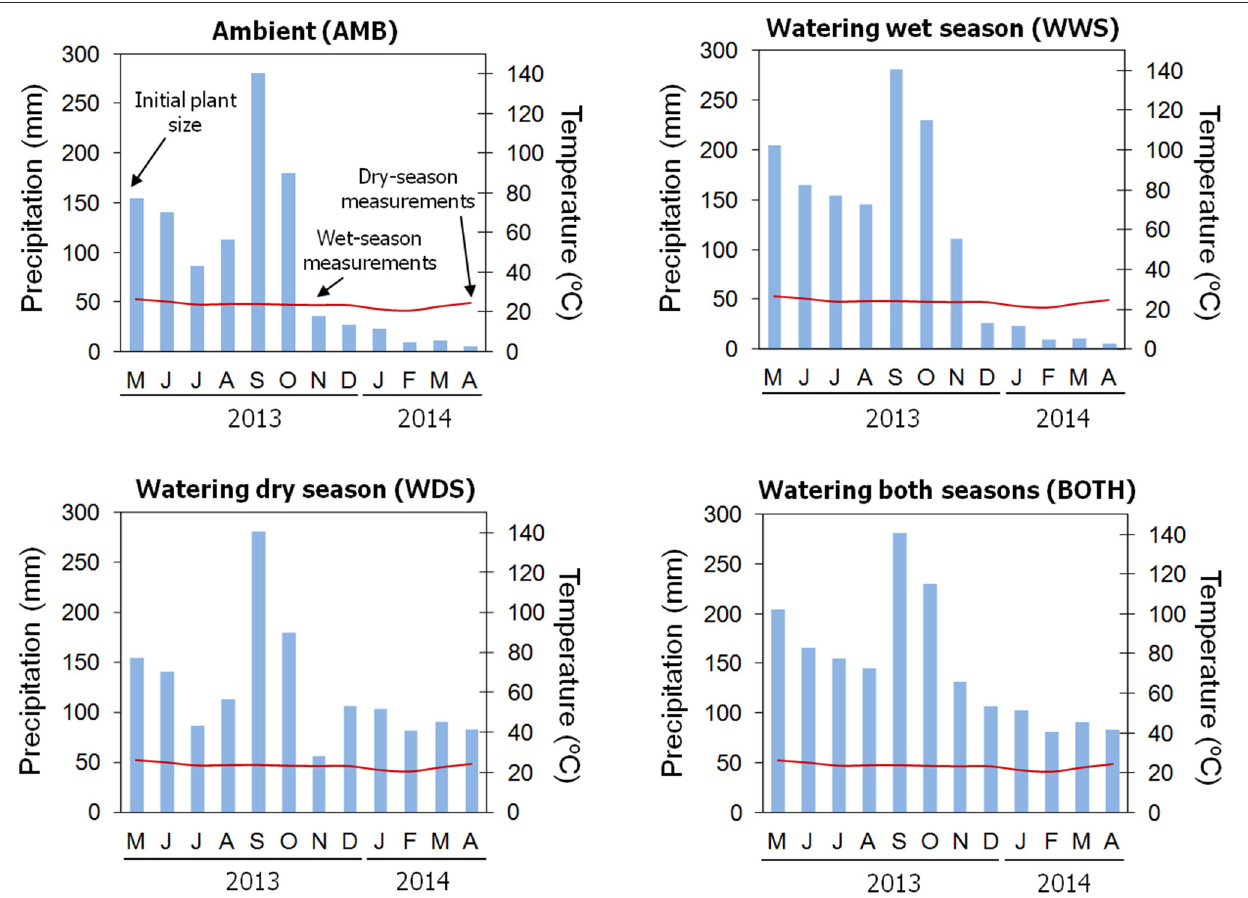
WDS and WWS protocols (hereafter BOTH). These treatments are representative of the natural precipitation gradient where